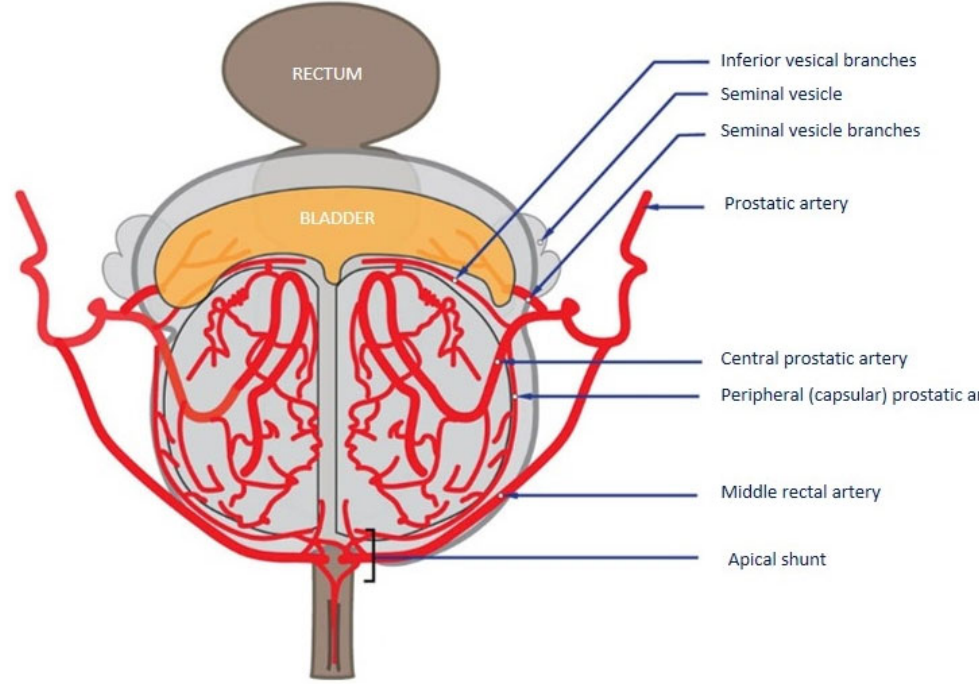
Figure 3. Examples of prostate artery occlusion and revascularization of the prostate via a distal pudendal/prostatic apical shunt. Image 1 : Internal iliac angiography demonstrating a vesical inferior artery (A), an obturator artery (B), and an internal pudendal artery (C). Note the occluded prostatic artery (arrow). Image 2 : Supraselective angiography of the internal pudendal artery (C) showing a connexion with the prostatic artery via an apical shunt (thin arrow). Image 3 : Retrograde catheterism of the prostatic artery (thin arrow) and opacification demonstrating opacification of the prostatic central branch (star) and confirming occlusion of a proximal prostatic artery (large arrow).